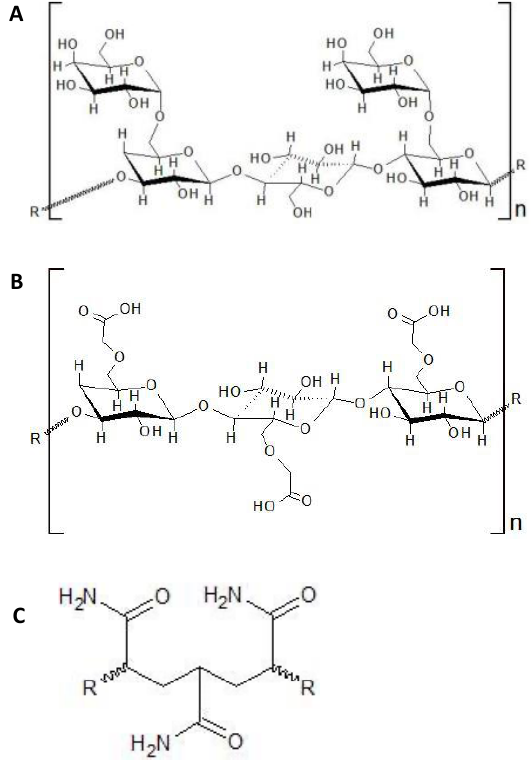
Figure 1. Chemical structure of ( A ) guar gum, ( B ) CMC, and ( C ) PAM.